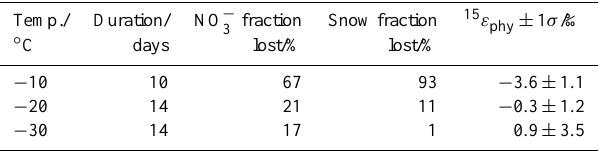
Table 2. Nitrate “physical release” experiments: isotopic fraction- ation constants calculated for each of the three experiments con- ducted at − 10 ◦ C, − 20 ◦ C and − 30 ◦ C (1- σ uncertainties calculated as in Frey et al., 2009).